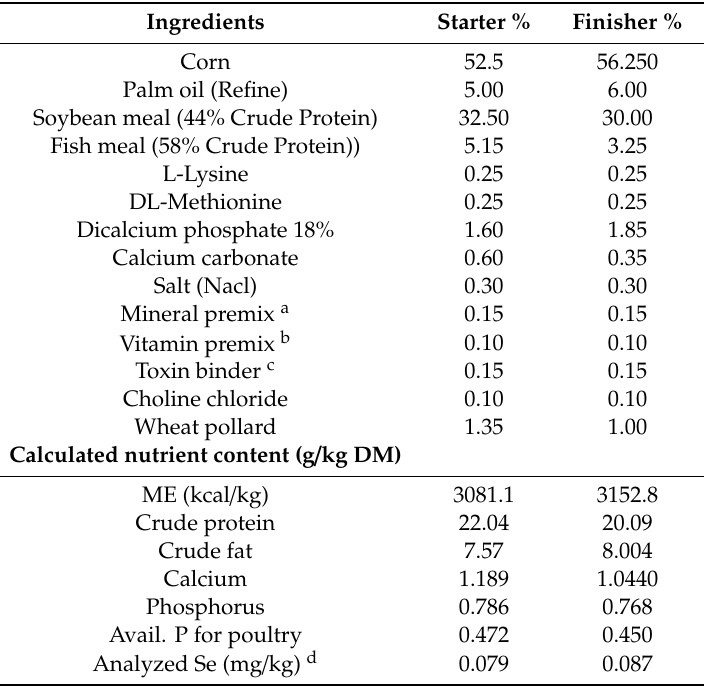
Table 1. Ingredients and nutrient content of the basal